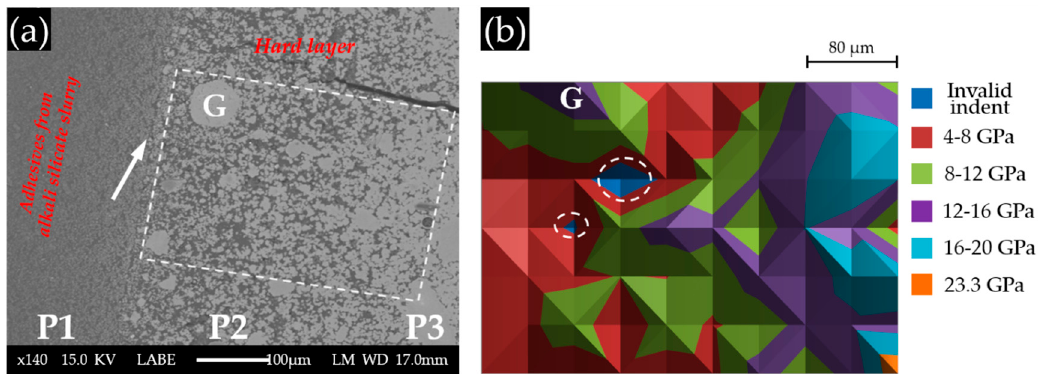
Figure 10. ( a ) The BSE image of S3 with a Ca(OH) 2 paste addition of 10 g; ( b ) the corresponding elastic modulus. P1, Part